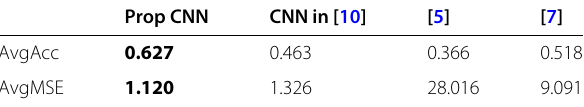
Table 2 Average performance of the proposed CNN estimator in the aligned case for QF 2 = 90, and comparison with the